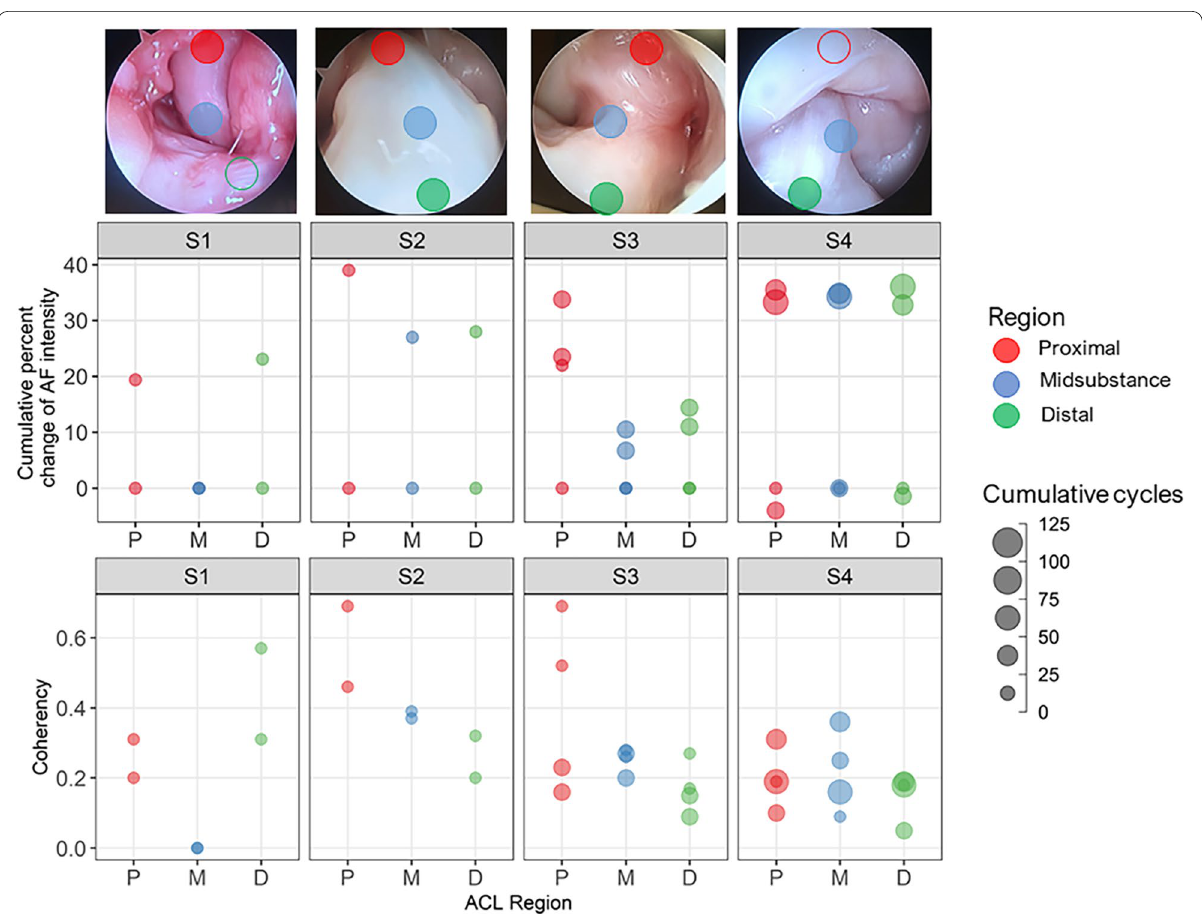
Fig. 5 Changes in AF intensity and coherency as a function of cumulative fatigue loading cycles separated by ACL region from single knee specimens. Approximate CLEM probe placement marked by circles in the proximal (red), midsubstance (blue) and distal (green) regions in AR image (top row). Open circles indicate continuation of ACL tissue but hidden by surrounding structures. Changes in AF intensity as cumulative percentage (middle row) and coherency (bottom row) as a function of cumulative fatigue loading cycles represented by increasing circle size for every 25 loading